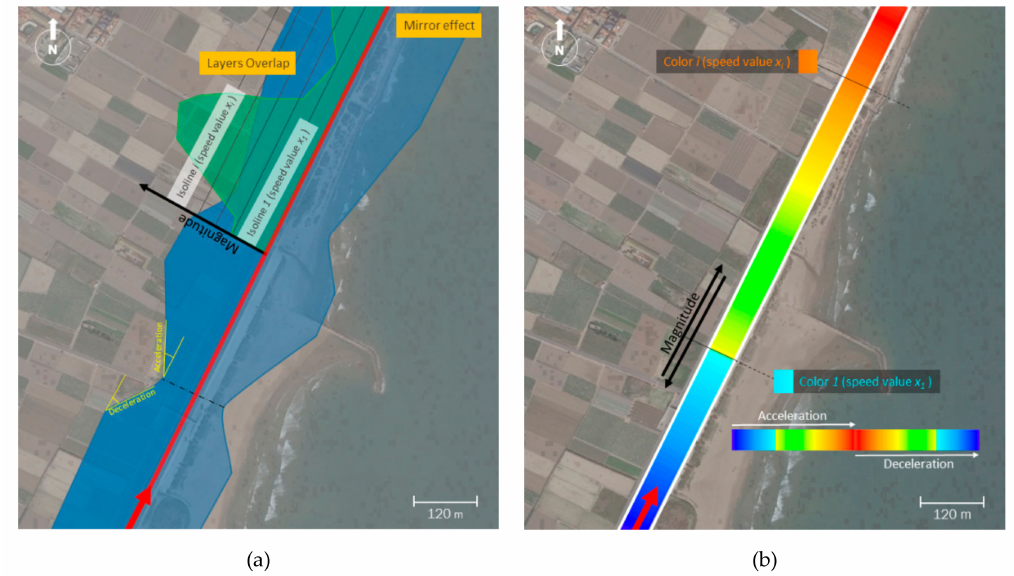
Figure 3. Methodology for the representation of kinematic driving parameters using attributes based on ( a ) geometries and ( b )